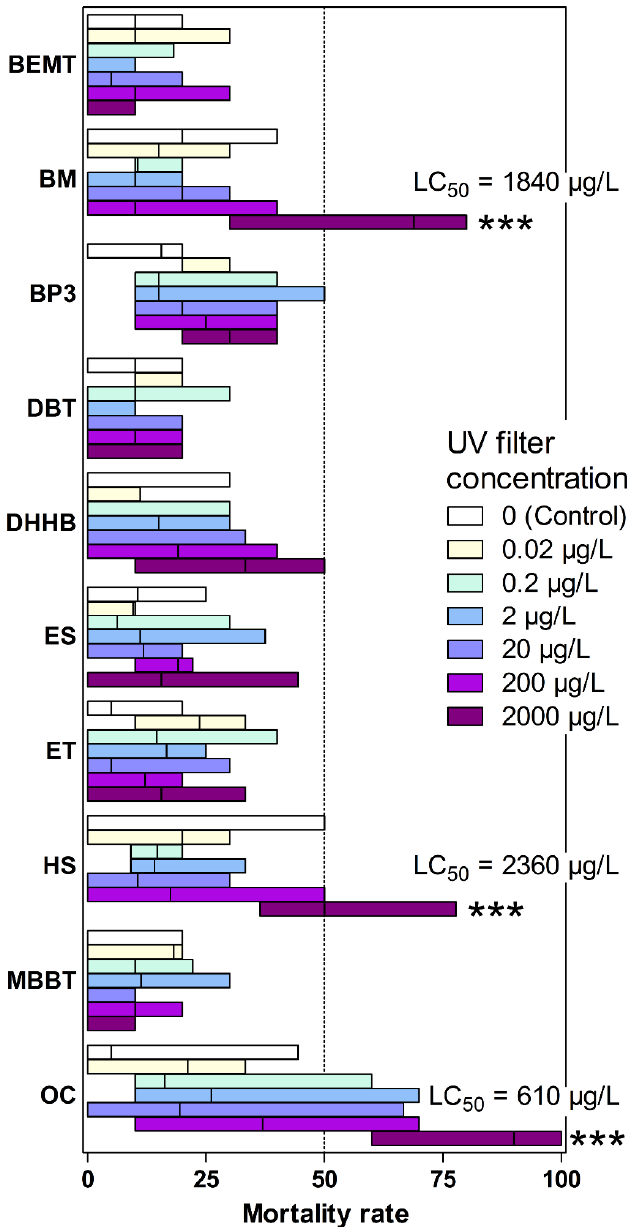
Figure 1. Mortality rate of A. salina exposed to the 10 UV filters at 6 concentrations. Boxes